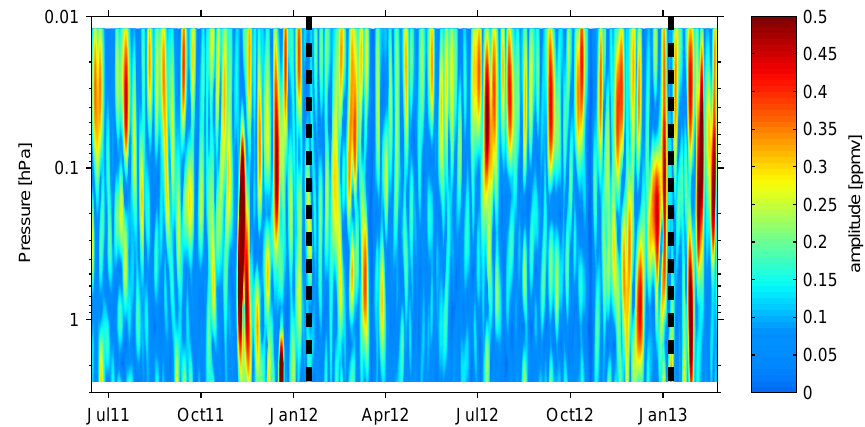
Figure 2. Amplitude of the 2-day activity in MIAWARA-Cs water vapour time series. The two black dashed lines mark the central dates of the two SSWs.